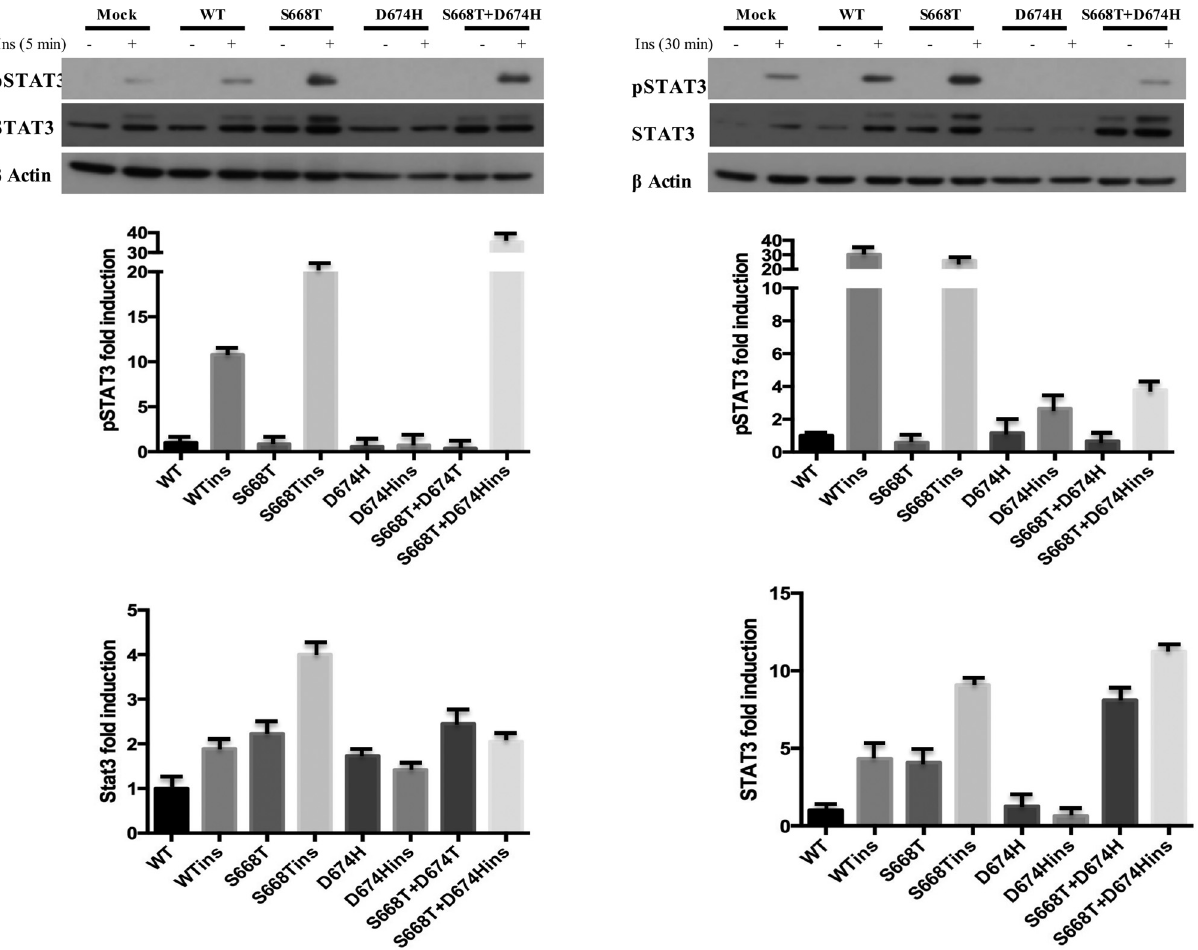
Figure4 -Insulin-inducedphosphorylationandexpressionofSTAT3isalteredbyS668TandD674Hmutantsin293Tcells.Onehundredmicrogramsof total protein was fractionated by 10% SDS-PAGE. Blots were probed with anti-phospho-specific antibodies, stripped and reprobed with non-phospho-specificantibody.Foldinductionofphosphorylationwasdeterminedbydividingdensitometricvaluesofphospho-bandtothatoftotalpro- tein bands. Relative abundance of STAT3 was determined by dividing the densitometric values of STAT3 to that of